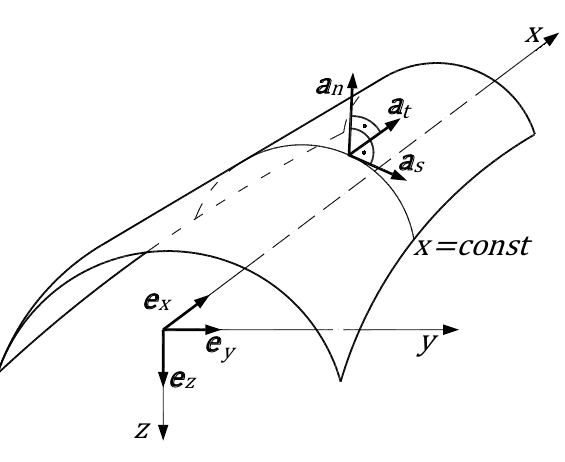
z Figure 2: Coordinate system and local basis vectors for nonprismatic thin-walled